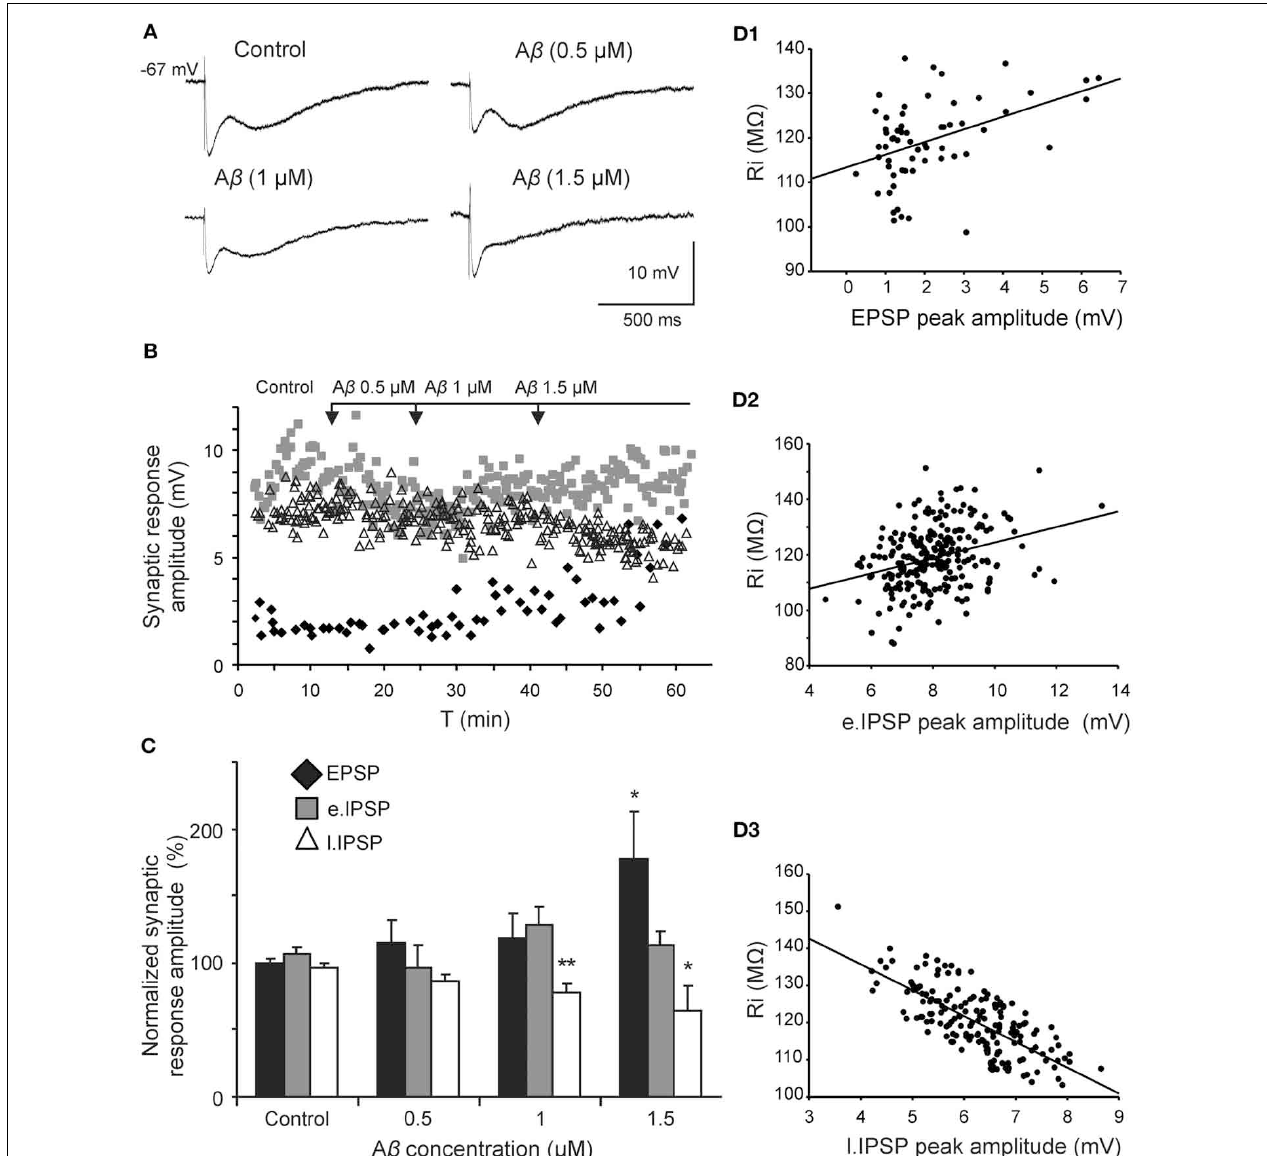
code in C ). (C) Histograms with relative mean amplitude ( n = 20) of the different components of the complex synaptic response (EPSP;